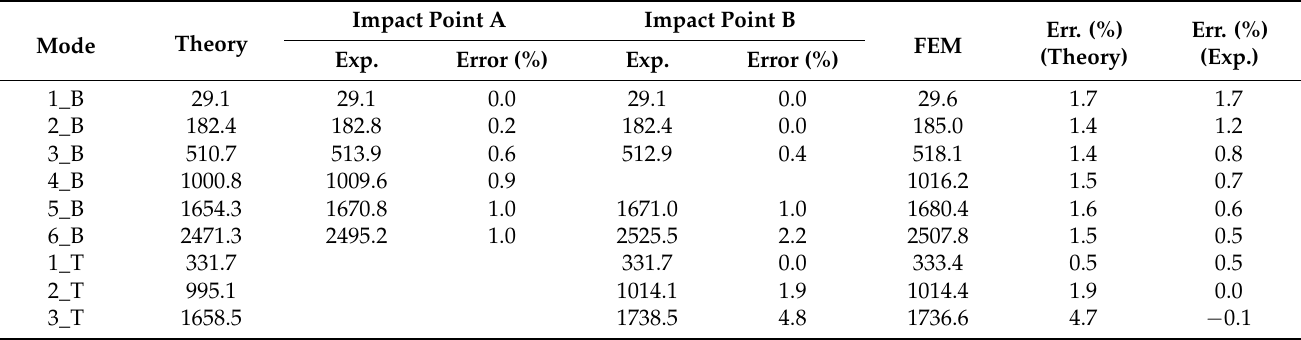
Figure 5. Time domain and frequency domain signals of xy plane– x direction test piece when hitting point B. Table 2. Natural resonance frequency of xy plane– x direction test piece.